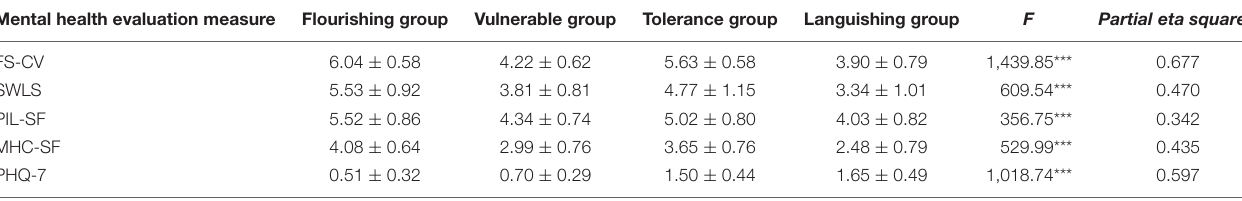
TABLE 3 | Comparison of college students’ positive and negative mental states across the four categories. Mental health evaluation measure